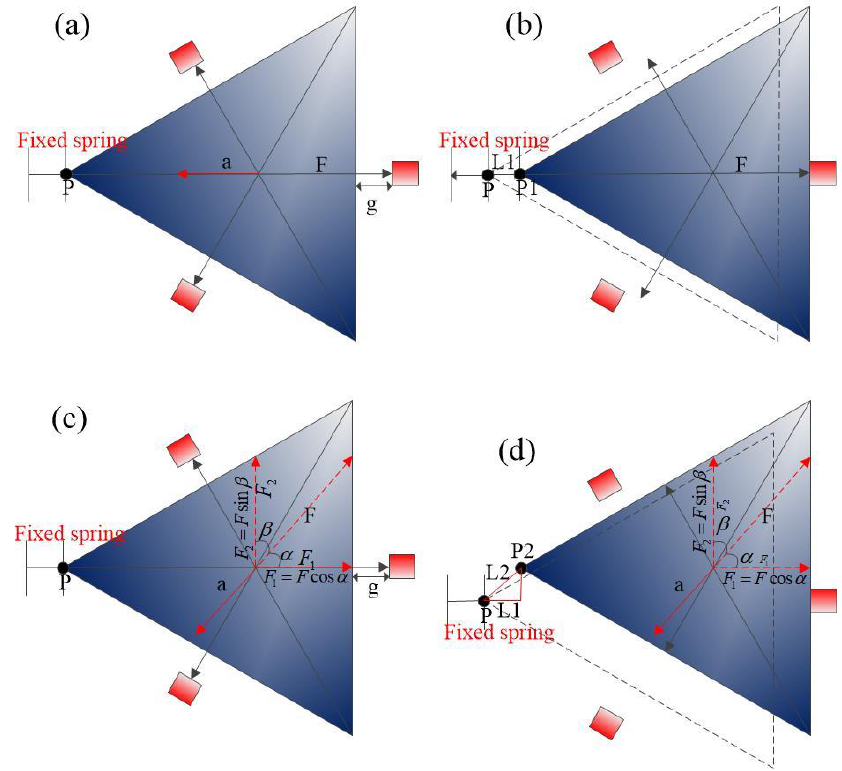
Figure 2. ( a ) The schematic diagram of a triangular movable electrode acting in a sensitive direction; ( b ) the movable electrode contacts with the fixed electrode in a sensitive direction; ( c ) the schematic diagram of a triangular movable electrode acting in a non-sensitive direction; ( d ) the movable electrode contacts with the fixed electrode in a non-sensitive direction.